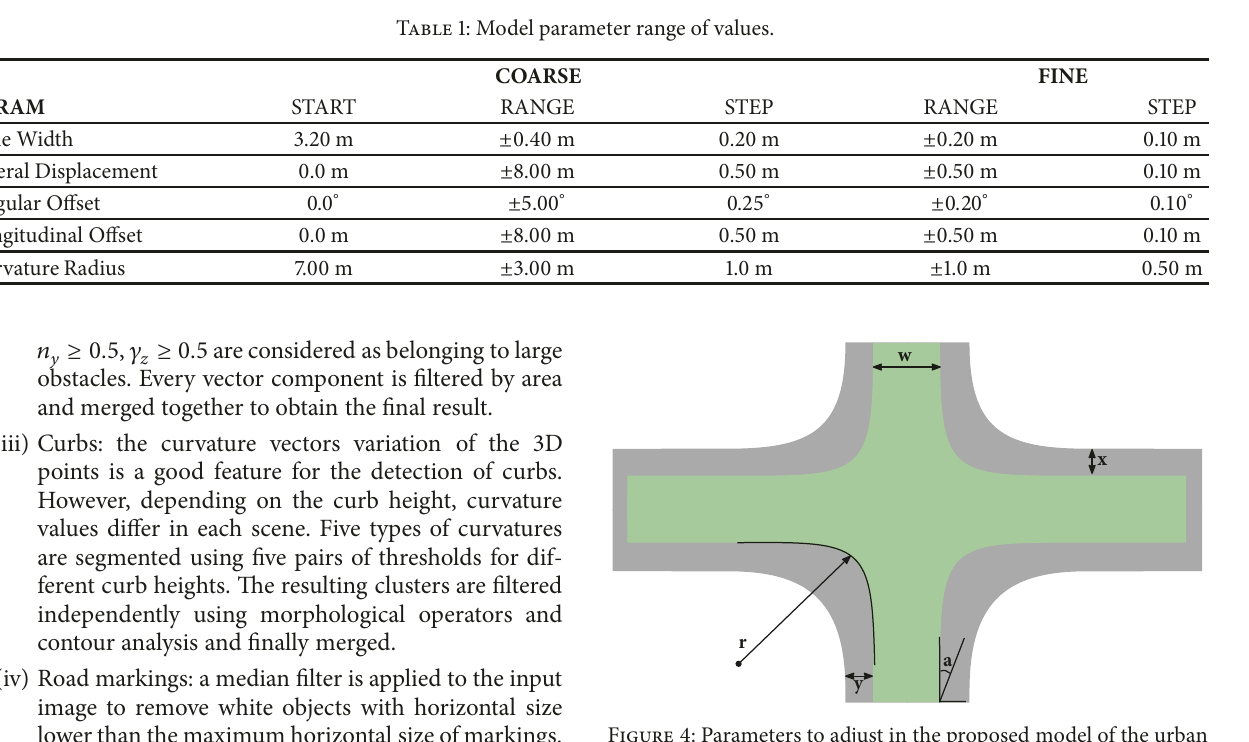
Figure 4: Parameters to adjust in the proposed model of the urban road. The real scene is painted in grey and the model to adjust is shown in